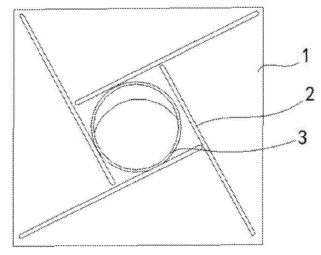
Figure 18. Landing platform with rotating pushers [57]. 1, landing platform; 2, rotating pushers; 3,